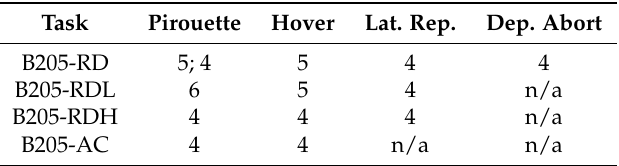
Table 5. Handling Qualities Ratings (HQRs)